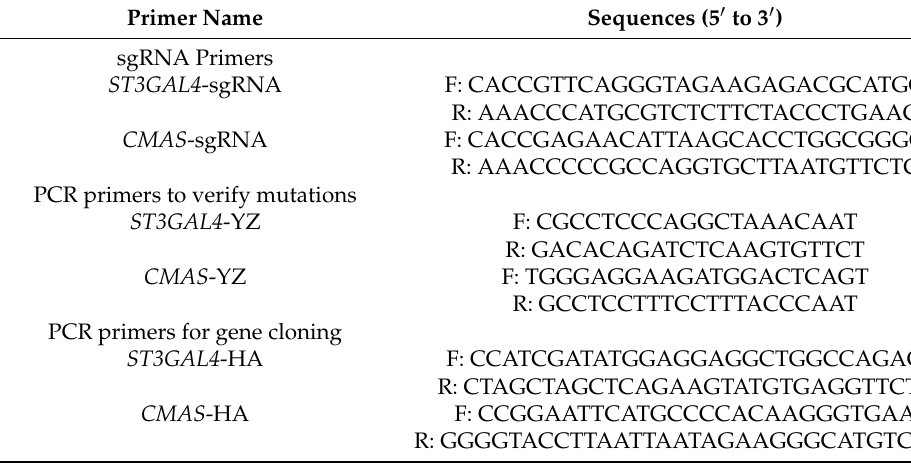
Table 1. Primers used for